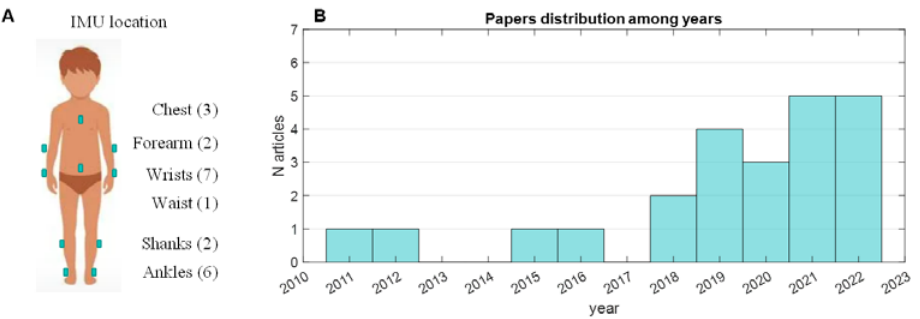
Figure 2. ( A ) Report of the different human body positions of the wearable inertial units described in the selected articles; ( B ) Classification of the articles based on the year of publication.